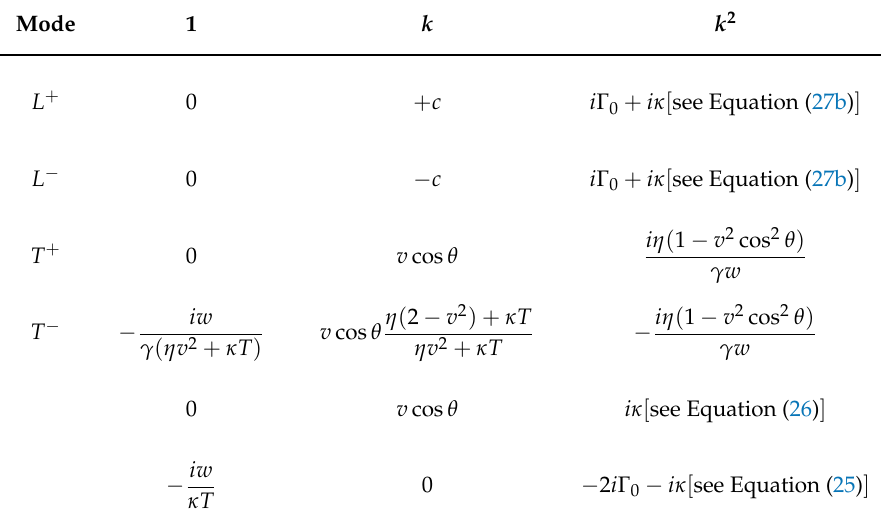
Table 1. Coefficients of the single-fluid modes in a low-momentum expansion of ω ( k ) up to k 2 , with v -dependence shown only where the expression is short enough, i.e., for L ± and the mode in the 6th row only the v = 0 result is given. The modes in the 4th and 6th row show an unphysical instability in first-order hydrodynamics. The modes of the bottom two rows only exist at nonzero temperature and play no role in our discussion of the two-fluid system, where we restrict ourselves to zero